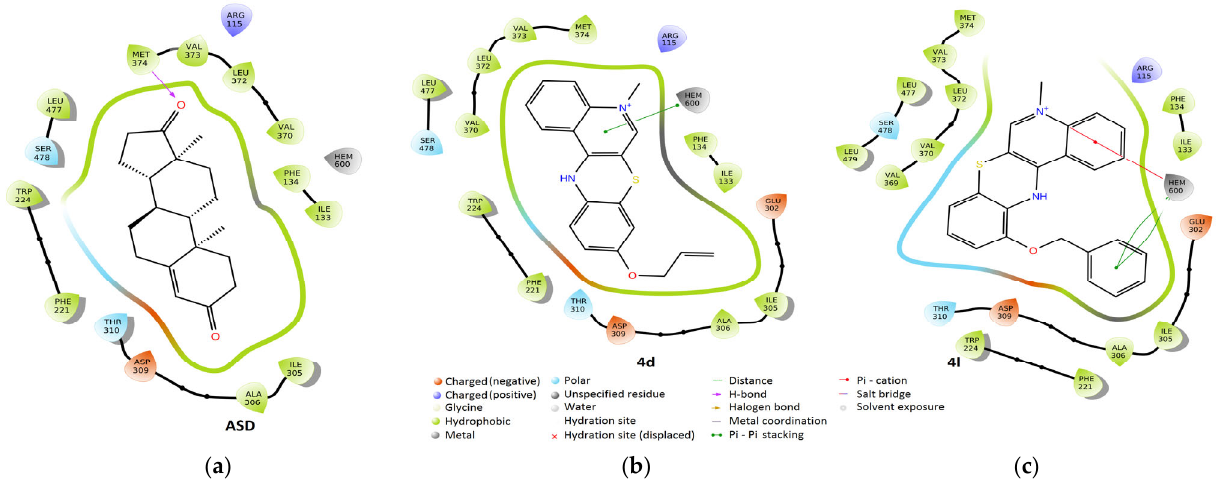
Figure 1. Planar ligand interaction diagram for 4 ‐ androstene ‐ 3 ‐ 17 ‐ dione ( a ) and the most potent inhibitors, 9 ‐ allyloxy derivative 4d ( b ) and 11 ‐ benzyloxy derivative 4l ( c ), generated by the Schrödinger Maestro program.